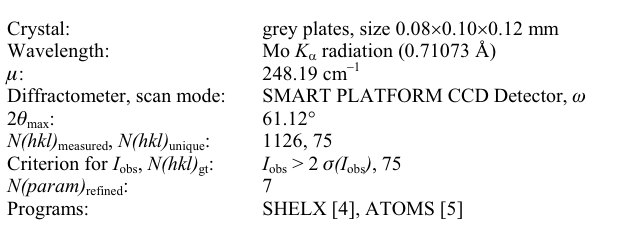
Table 1. Data collection and